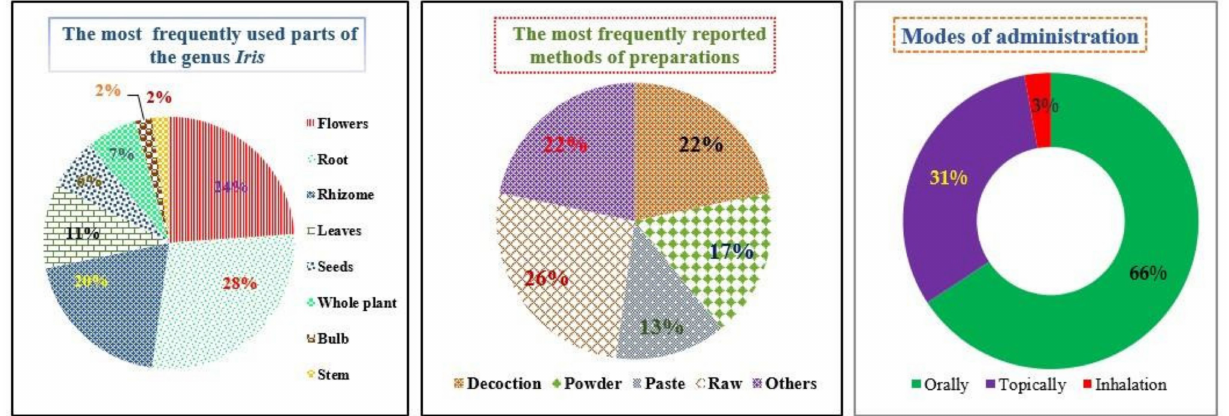
Figure 2. The most frequently used parts, methods of preparation and administration of Iris spp. according to several ethnobotanical